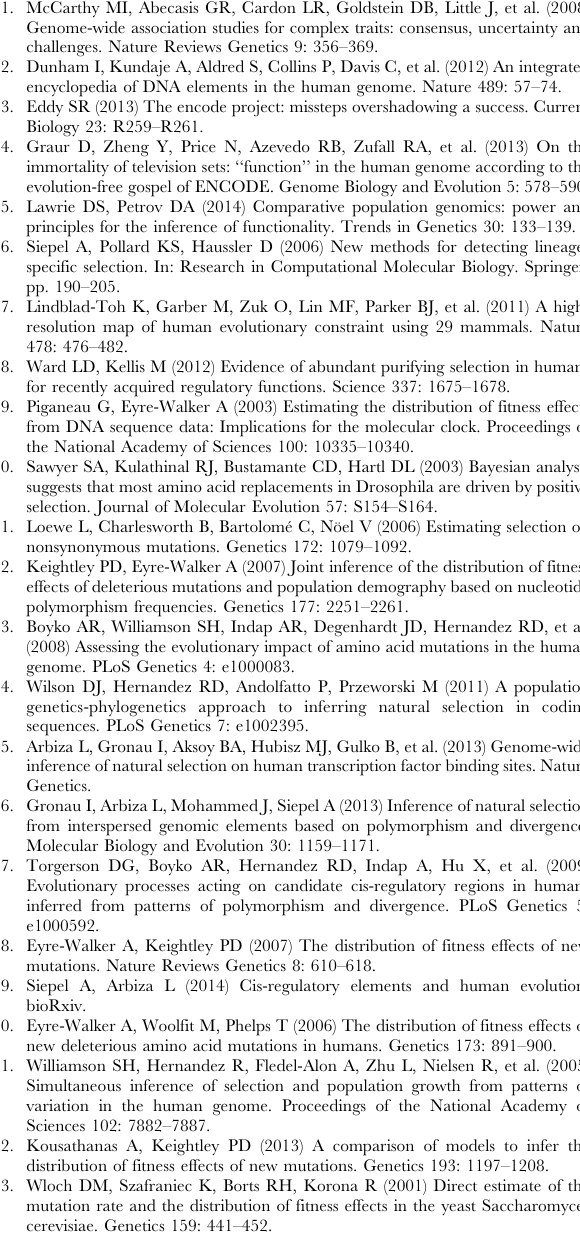
the log base 10 of the standard deviation of coefficients in each